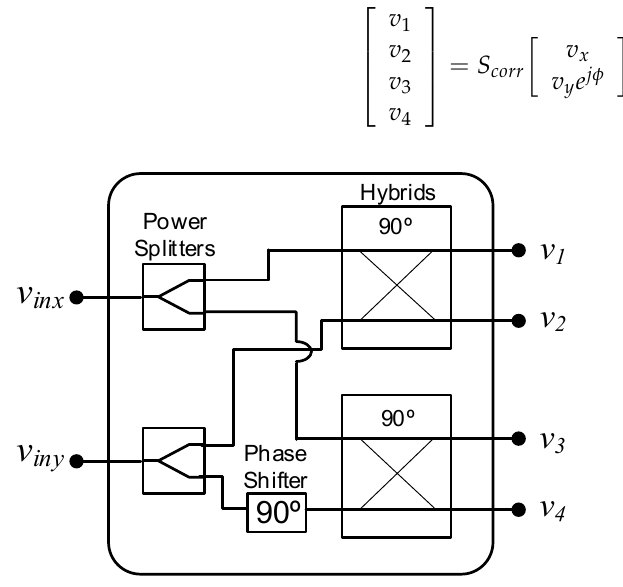
Figure A4 . Schematic of the correlation module. Figure A4. Schematic of the correlation